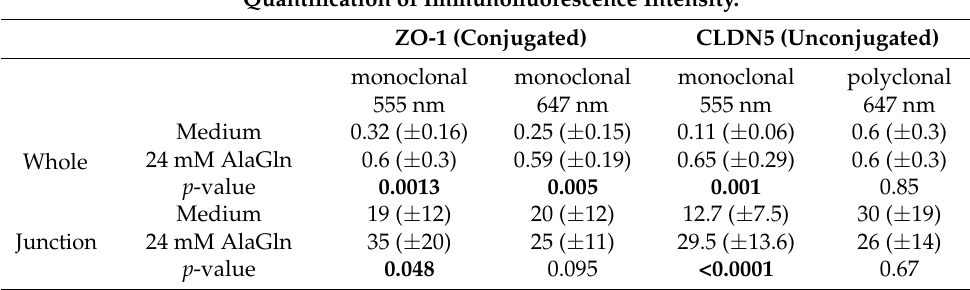
Table 1. Immunofluorescence intensity quantification (in arbitrary units; A.U. grey scale image fluo- rescence signal normalized to analyzed area) performed on maximum z-projection after incubation with 24 mM AlaGln for 24 h. Antibodies with different characteristics were used to quantify ZO-1 and CLDN5 abundance either on the whole image or limited to junction area at the cell-cell contact and resulted in similar findings for ZO-1, but not for CLDN5. Quantification of Immunofluorescence Intensity. ZO-1 (Conjugated) CLDN5 (Unconjugated) monoclonal monoclonal monoclonal polyclonal